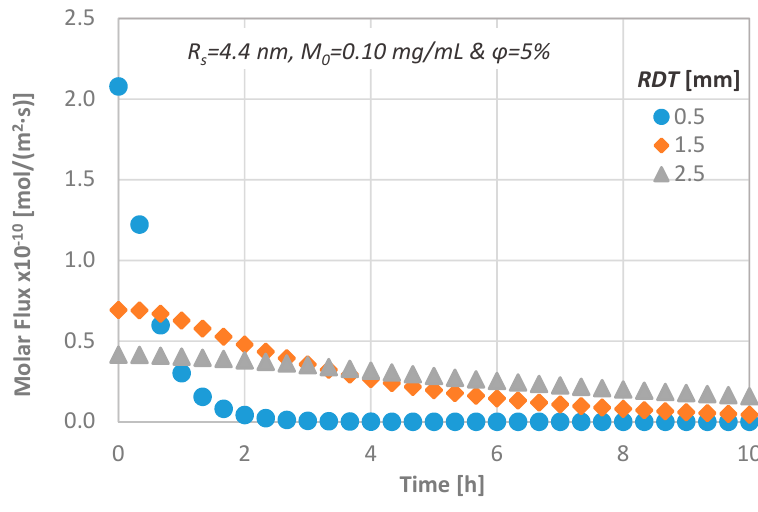
Figure 8. Effect of the RDT on the diffusion characteristics; molar flux versus time.